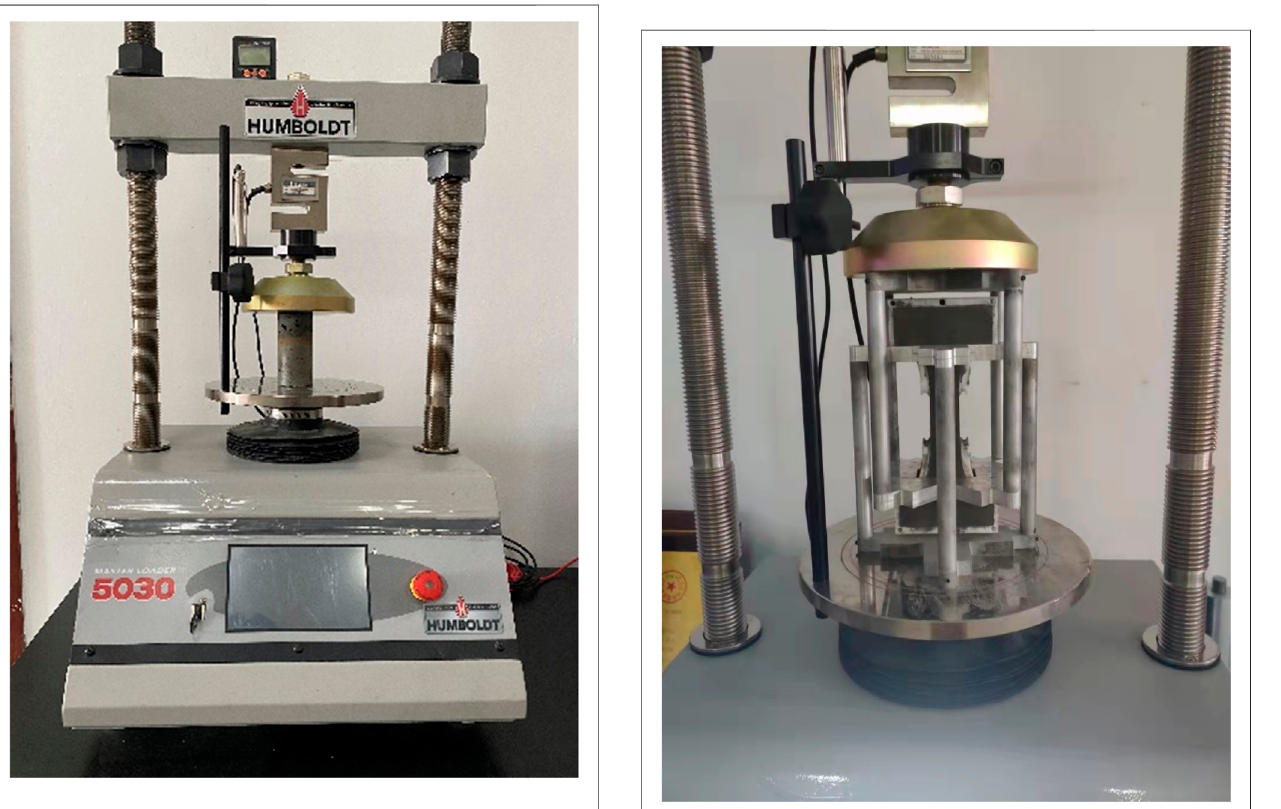
FIGURE 4 | Uncon fi ned compressive test of the cylindrical CPB specimen. FIGURE 5 | Direct tensile test of the dog-bone CPB